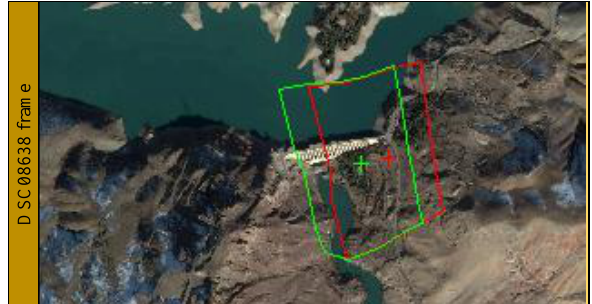
Figure 8. Geo-located image boundaries resulted from coarse (red) and fine (green) geo-location stages for four example frames shown in Figure